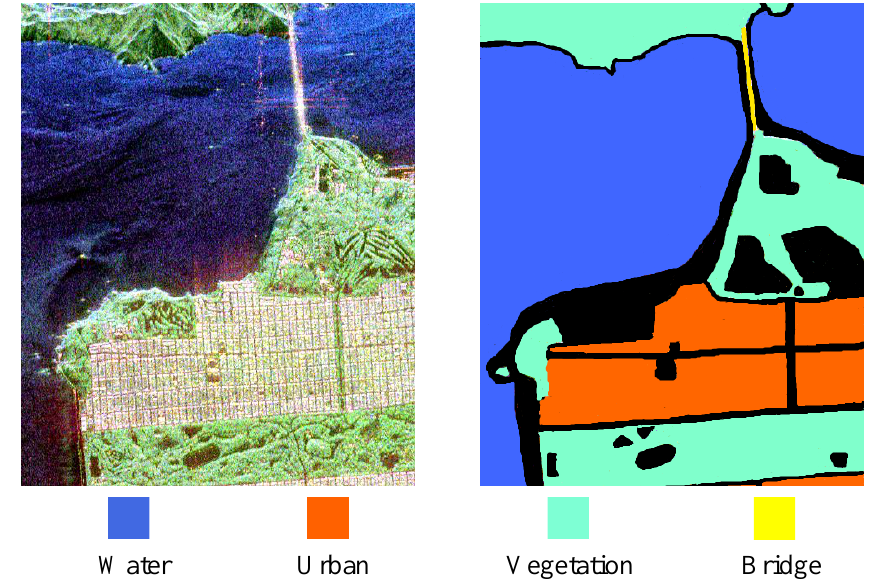
Figure 20. (Left) The false color image of San Francisco and (right) the ground truth image, where that black regions are without accurate class